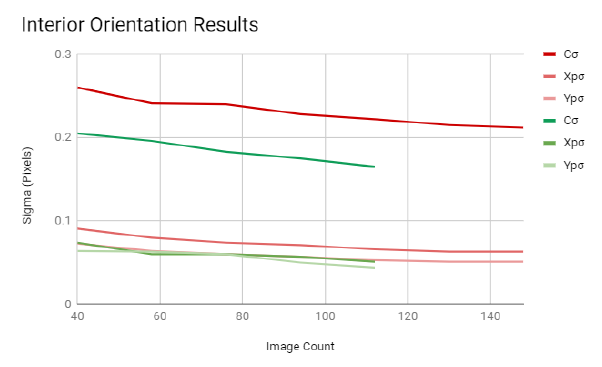
Figure 4. Interior Orientation Results for M4 (green) and M5 (red) as additional images are continually added in an attempt to further improve orientation parameters.